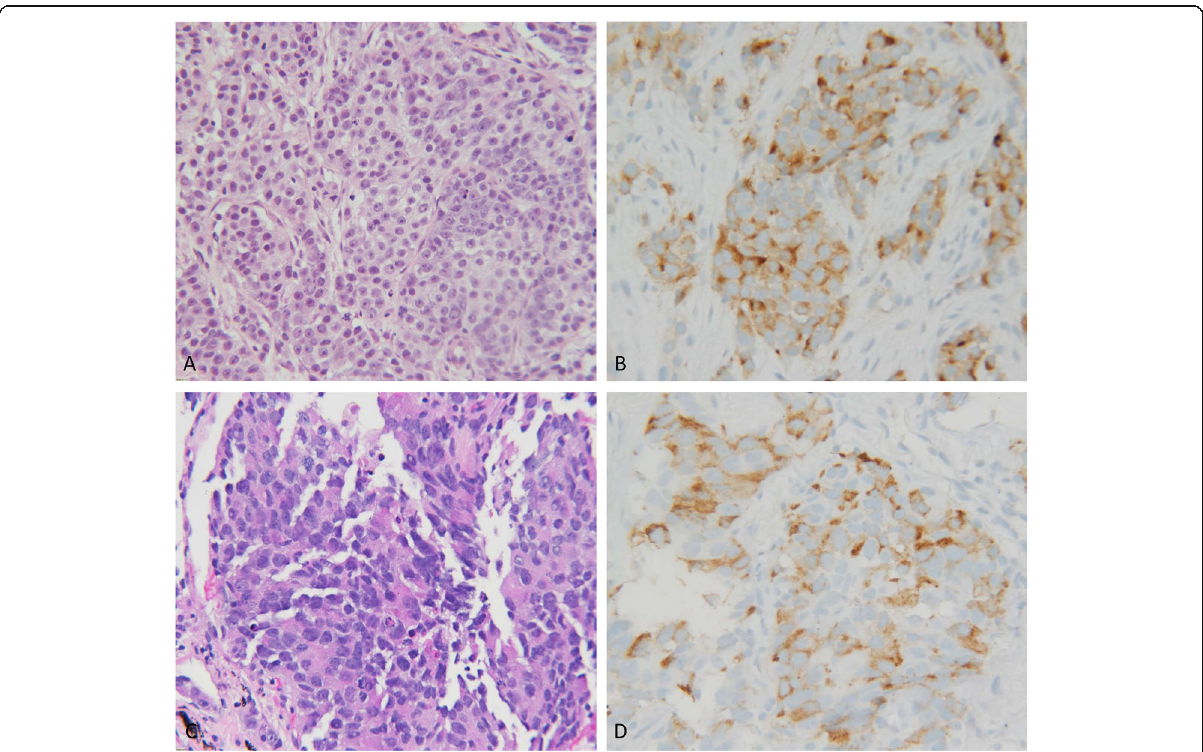
Fig. 1 Prostate adenocarcinoma showed PSMA positivity in tumor cell pattern. a . Primary prostate adenocarcinoma (PSMA, 200x); b . Metastatic prostate adenocarcinoma (PSMA, 200x); c , d . Metastatic prostate adenocarcinoma (C. HE, 200x; D. PSMA,